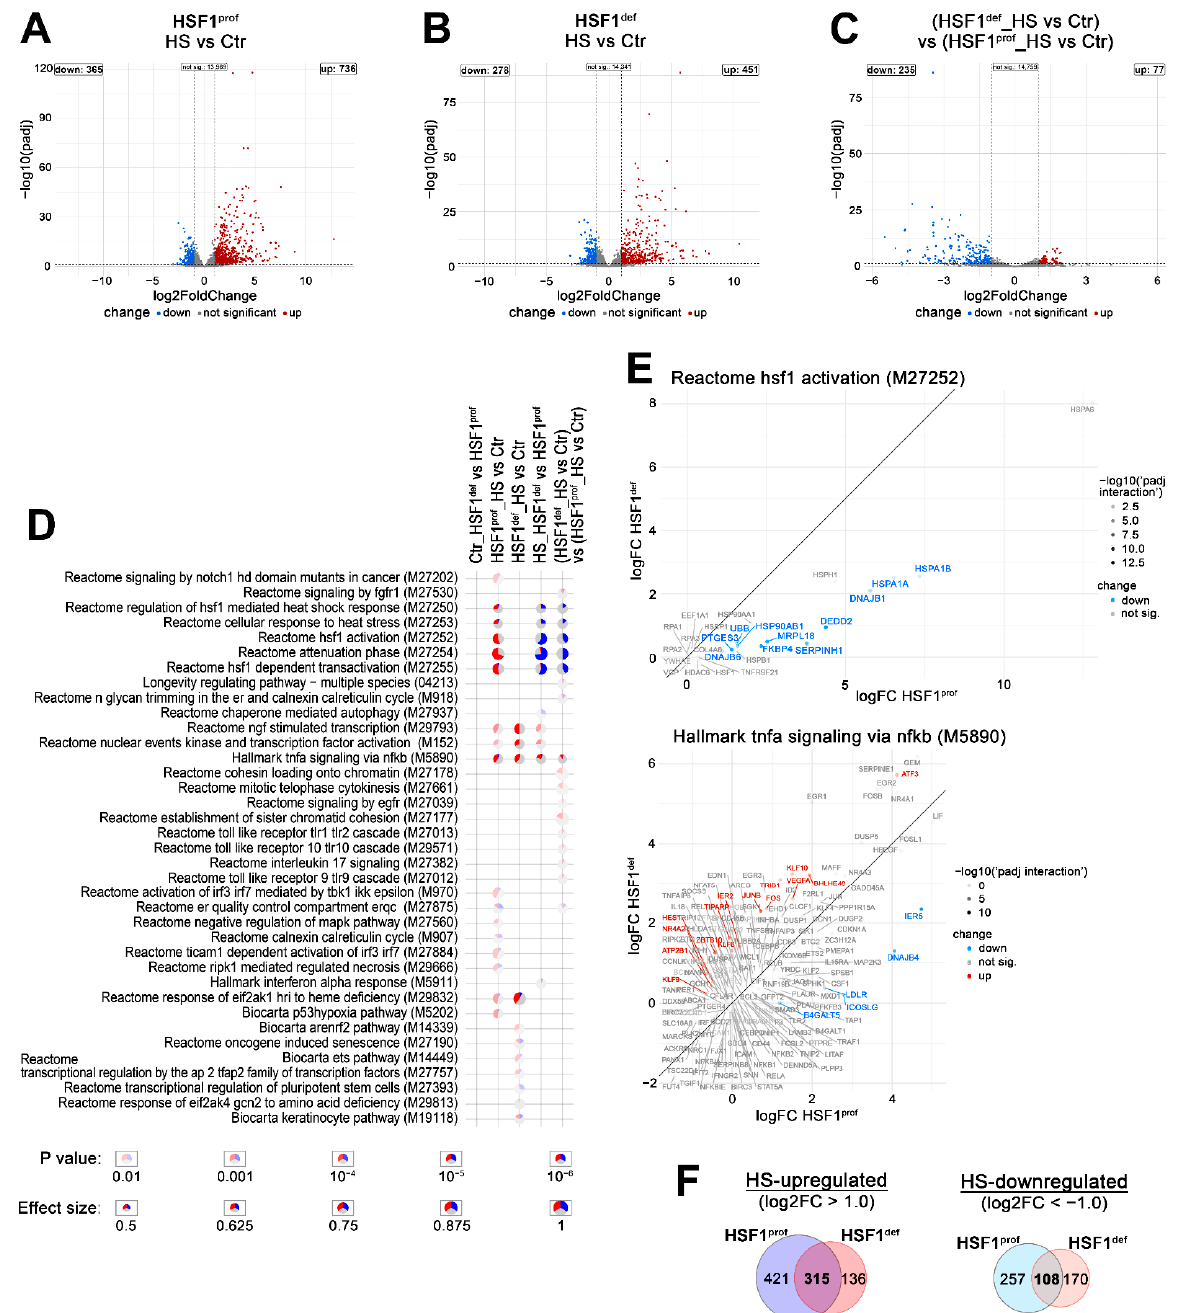
Figure 1. HSF1 deficiency affects the transcriptional response to heat shock in MCF7 cells. ( A – C ) Volcano plots of RNA-seq results showing the differentially expressed genes in response to heat shock (HS) in cells with normal ( A ) and reduced ( B ) levels of HSF1 (HSF1 prof and HSF1 def , respec- tively), and a comparison of the response in both cell variants: changes induced by heat shock in HSF1-deficient cells were compared to changes induced in HSF1-proficient cells ( C ). Plots with gene labels are shown in Figure S2C. ( D ) Geneset enrichment analysis showing significant terms from the Hallmark, Reactome, BioCarta, Pid, and KEGG gene sets collection detected in heat-shocked HSF1 prof and HSF1 def cells, as well as differences between cell variants. Blue—a fraction of downregulated genes, red—a fraction of upregulated genes. ( E ) Scatterplots of log2-fold-changes of genes associated with selected genesets upon HS stimulation in HSF1 prof (on X -axis) and HSF1 def ( Y -axis) cells. ( F ) Overlap of genes stimulated or repressed after heat shock in both cell line